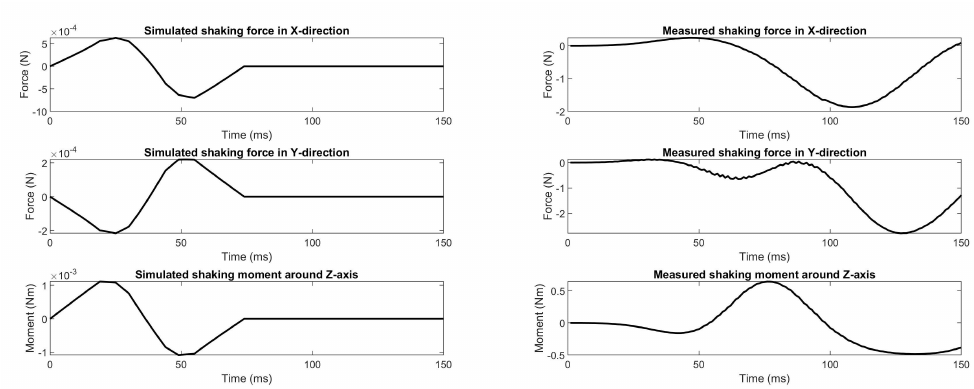
Figure 17. Comparison of the simulated and the measured shaking forces and shaking moment of the prototype for a maximal tip acceleration of just over 21